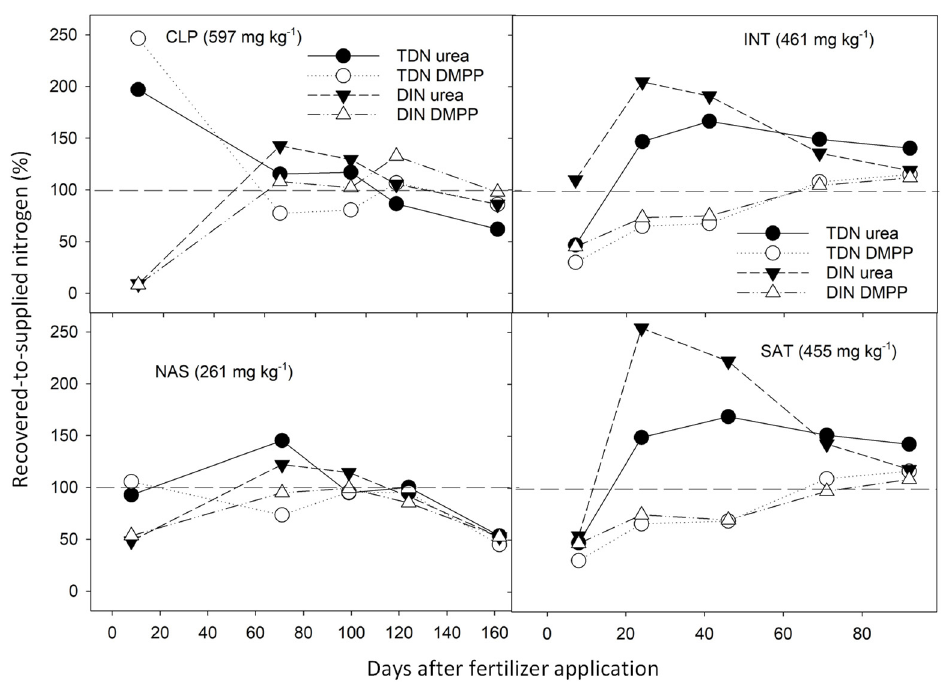
Figure 4. Total dissolved N (TDN) and dissolved inorganic N (DIN) in soil from root exclusion cylinders (recovered N), divided by supplied N (that is, N applied as urea or DMPP-coated urea plus TDN or DIN in unfertilized soil), expressed as a percentage. Dashed line is 100%. Days after fertilizer application refers to the time when cylinders were removed from the soil in 2016–2017 (CLP and NAS), and 2017–2018 (INT and SAT), respectively.